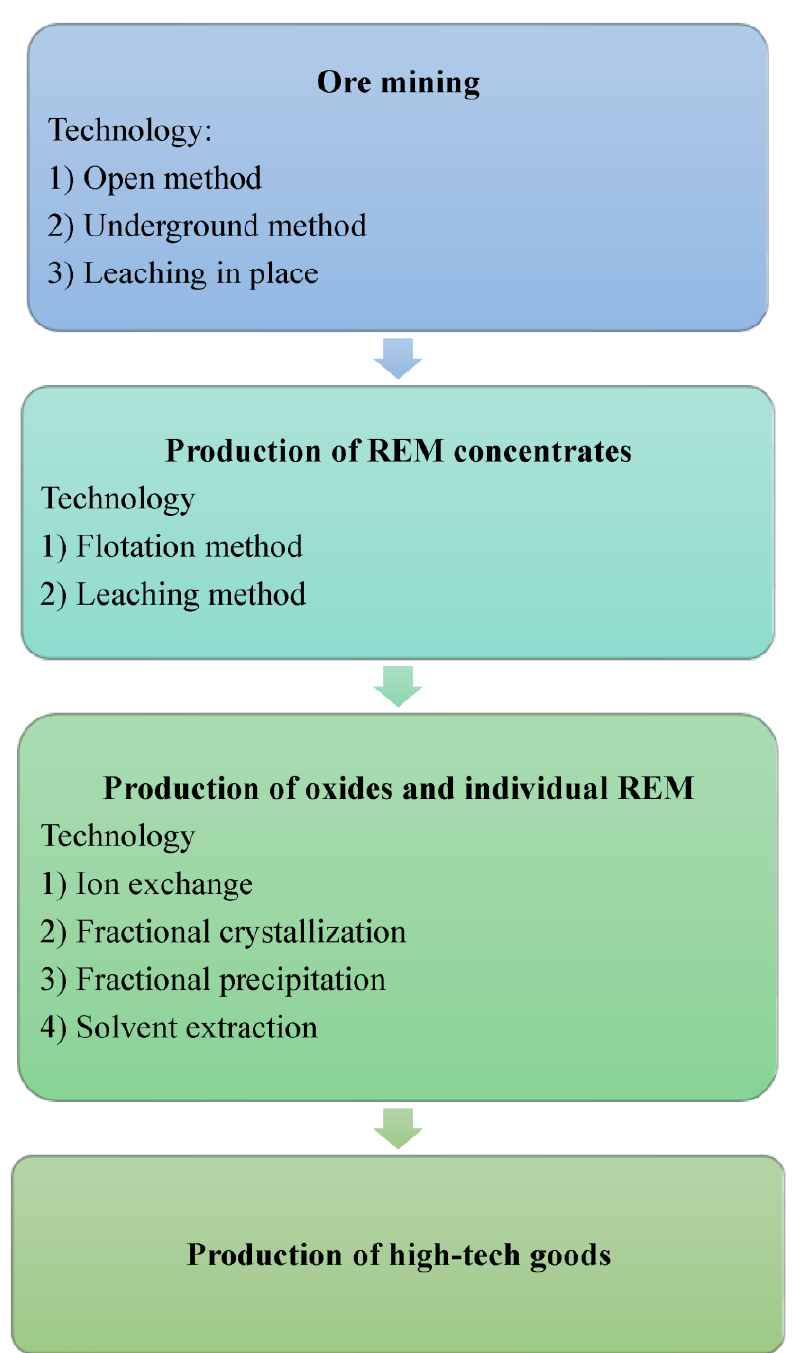
Figure 1. The structure of the technological chain for the production of high-tech products based on REMs.